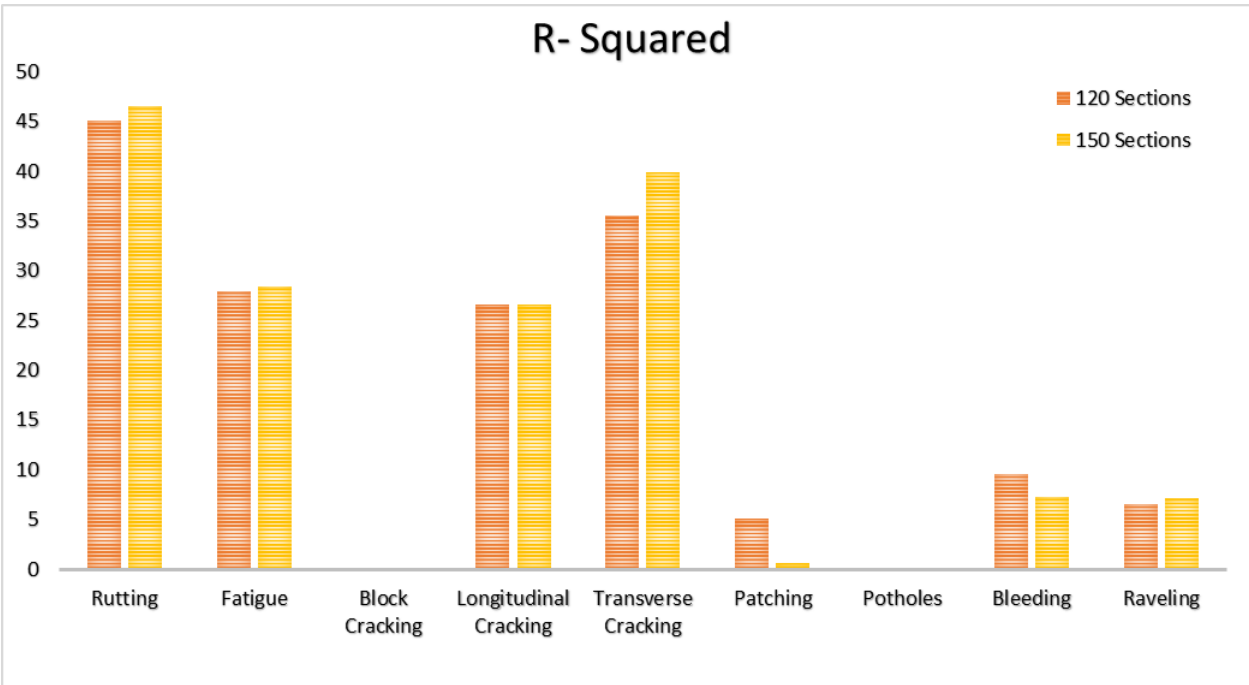
Figure 6. Sensitivity analysis of input variables on prediction for FPCI.